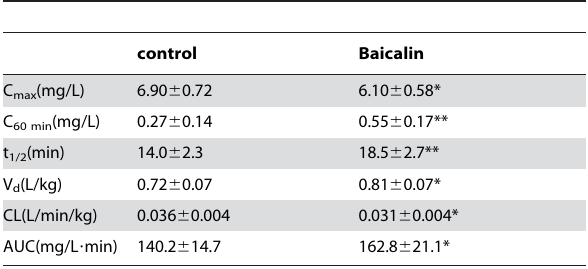
Table 4. Pharmacokinetic parameters of phenacetin (5 mg/ kg, i.v.) after treatment with baicalin (450 mg/kg,